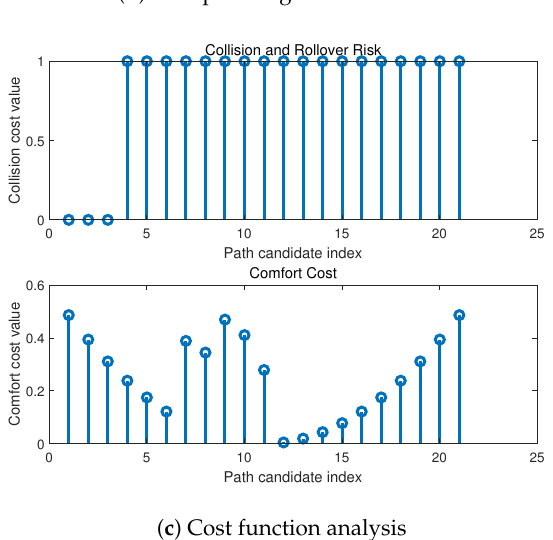
Figure 12. Multiple obstacle path selection: ( a ) an XY view on obstacles; the light color indicates z > 0; the dark color indicates z < 0; ( b ) path selection result in a three-obstacle model: the selected path avoids two rollover risk obstacles and passes over a non-rollover risk obstacle; ( c ) path candidate collision and rollover cost analysis and comfortability cost analysis